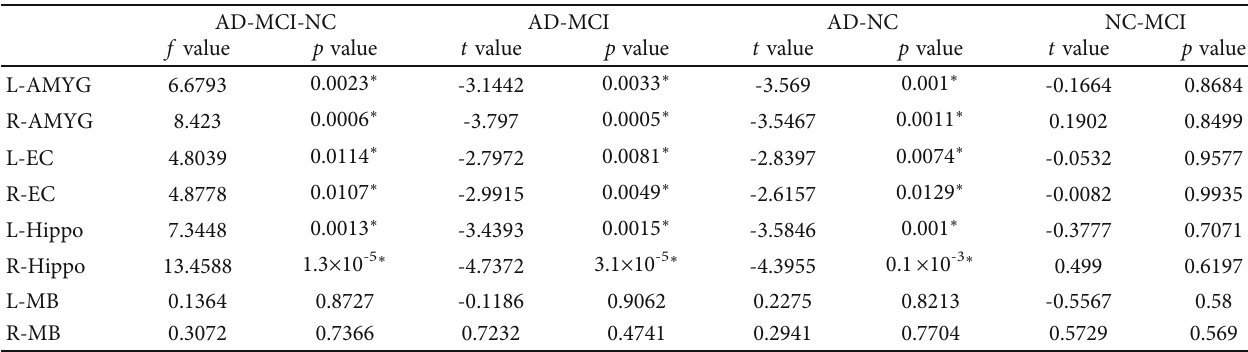
Table 3: Results of the ANOVA test and multiple comparisons of bilateral ROIs ’ GM densities of the three groups. The di ff erences of the densities of the bilateral hippocampus, amygdala, and entorhinal cortex in the comparisons of AD-MCI-NC, AD-MCI, and AD-NC were statistically signi fi cant ( p < 0 : 05 ) but not that obvious in comparison with MCI-NC ( p > 0 : 05 ); the di ff erences of the density of the mammillary body were not notable in the random comparison between these three groups ( p > 0 : 05 ).